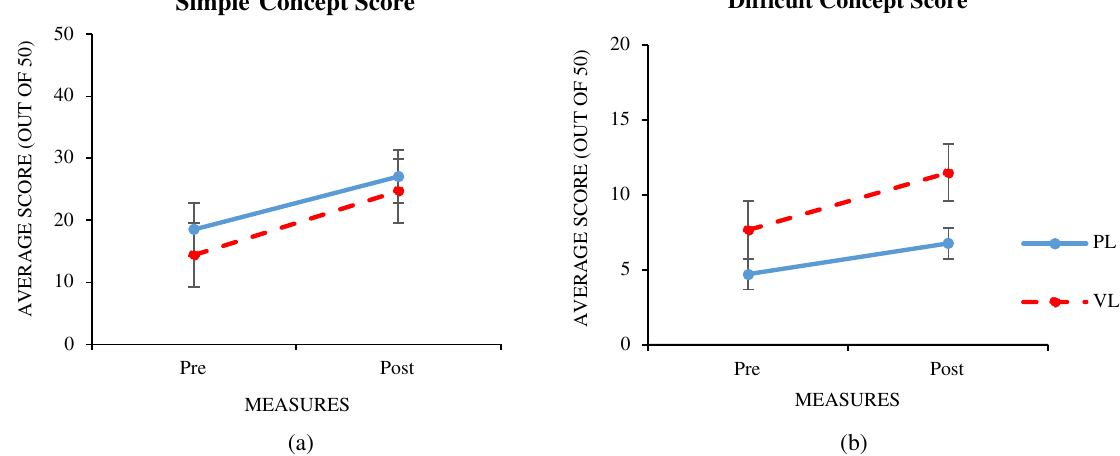
FIG. 1. (a) The enhancement of simple concepts for the PL and VL. (b) The enhancement of difficult concepts for the PL and